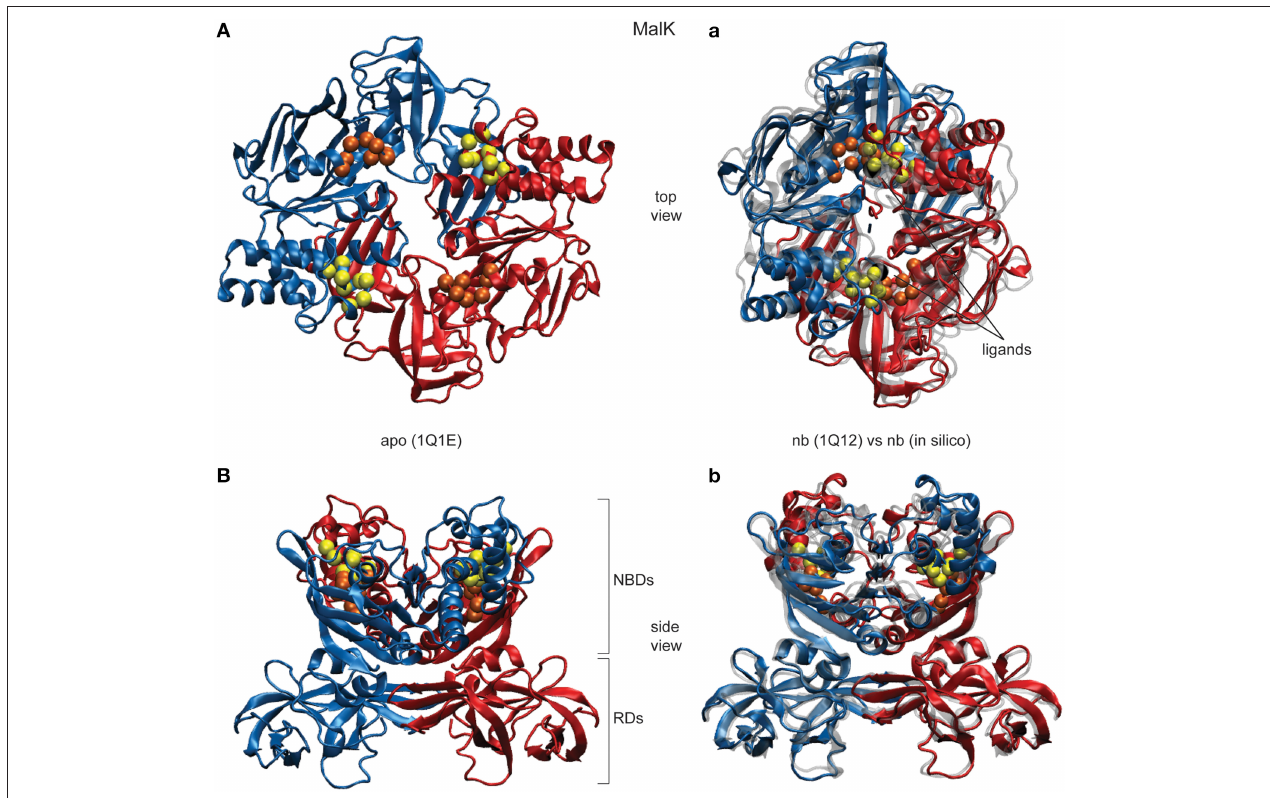
FIGURE 2 | Nucleotide-induced conformational changes in the MalK dimer. (A,B) The apo crystal structure in ribbon representation is shown in top and side view perspective. Chain A is colored blue and chain B is shown in red. The alpha-carbon atoms from residues belonging to the Walker A motif in each chain are shown as orange beads. Those corresponding to the ABC signature motifs are colored in yellow. In the side view the subdomain organization of nucleotide-binding domain (NBD) and regulatory domain (RD) in each chain becomes apparent. (a,b) Comparison of modeling results and the ATP-bound crystal structure. A single ligand-complexed conformation obtained after modeling of nucleotide binding (in solid coloring) is superimposed with the ATP-bound experimental structure (in transparent gray). The two bound ligands are shown as black beads.